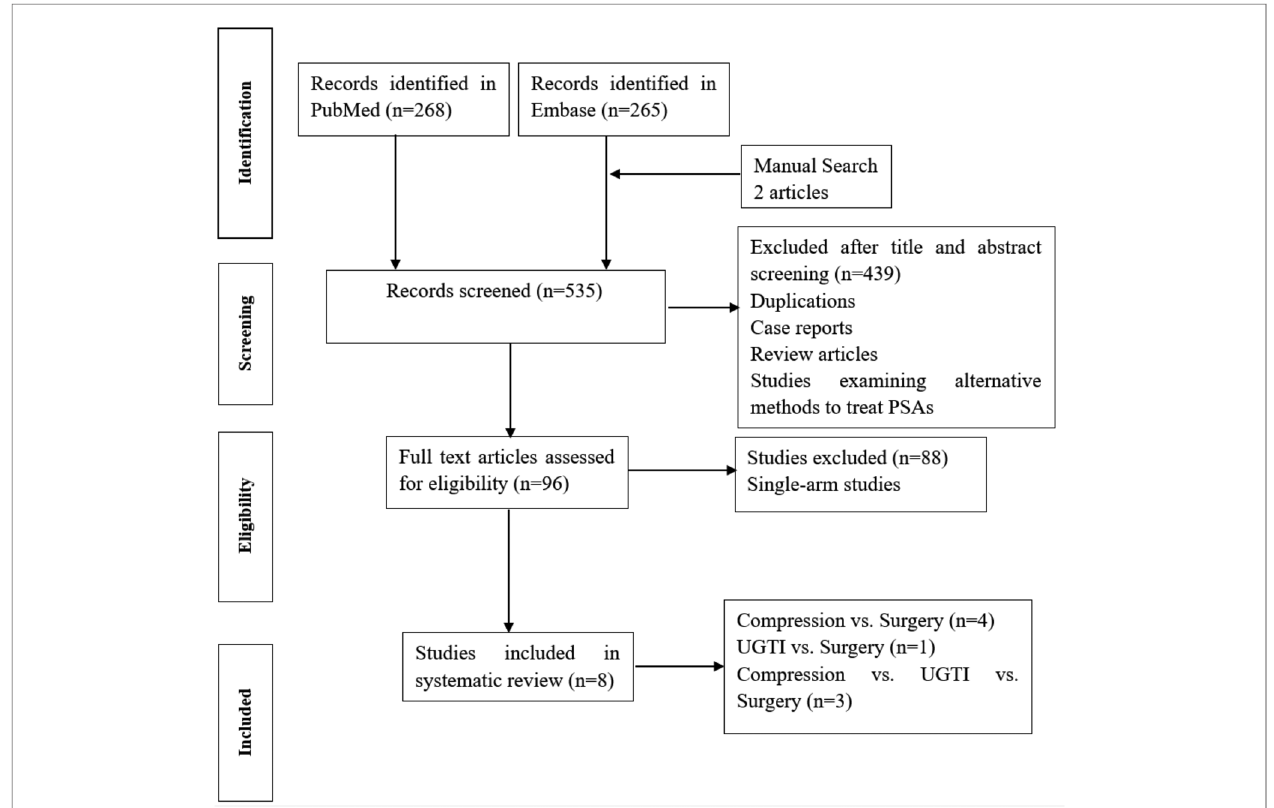
FIGURE 1 | Literature search fl